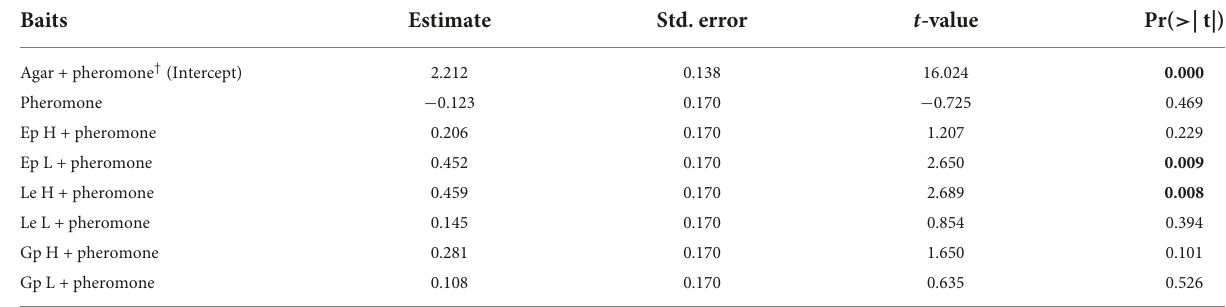
TABLE 2 Field attraction of Ips typographus to ophiostomatoid fungi. The table shows the results of contrast comparison estimated from a linear mixed model, log (Relative catches of I. typographus ) ∼ Baits + (1| Year). Baits contain aggregation pheromone in combination with various loads of different live fungal